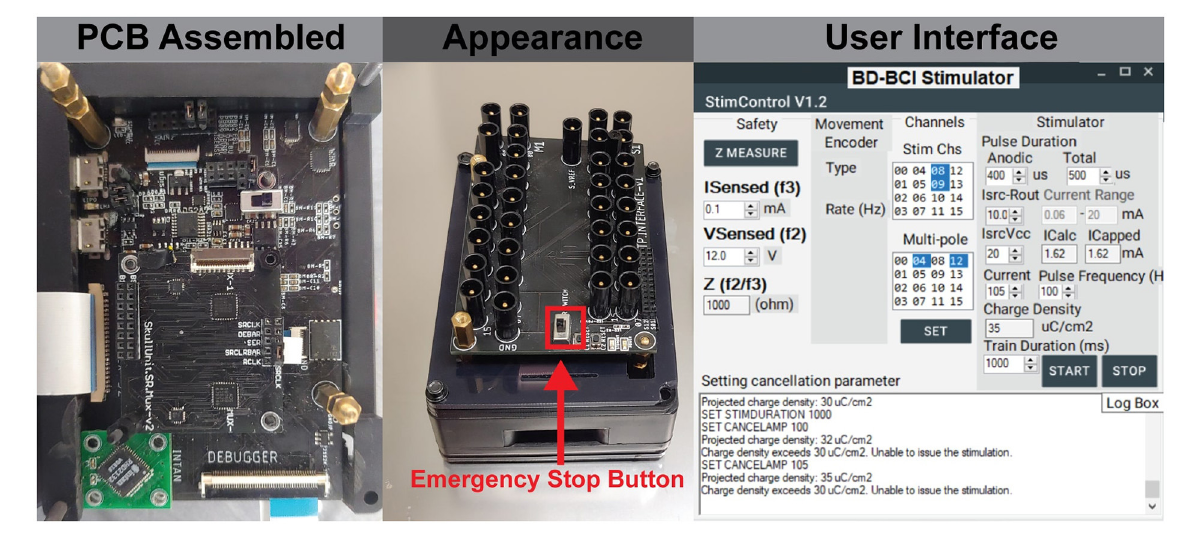
FIGURE5 (Left) The assembled board which includes embedded system on modular printed circuit boards. (Center) The final appearance of the BD-BCI stimulator enclosed in a case, and 1.5 mm touch proof interfaces on the top for connecting ECoG electrodes. (Right) The GUI which provides user control of all stimulation parameters and electrode pairs